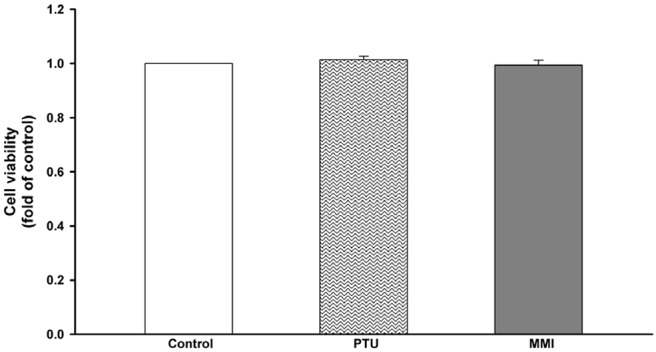
Viability of HepaRG cells following exposure to anti-thyroid drugs (ATDs), 6-n-propyl-2-thiouracil (PTU), and methimazole (MMI). HepaRG cells were exposed to PTU (31 μM), or MMI (3.42 μM) for 24 h. Cell viability was monitored by cellular acid phosphatase activity using PNPP as a substrate. The data shown are the mean ± SD (n = 3).